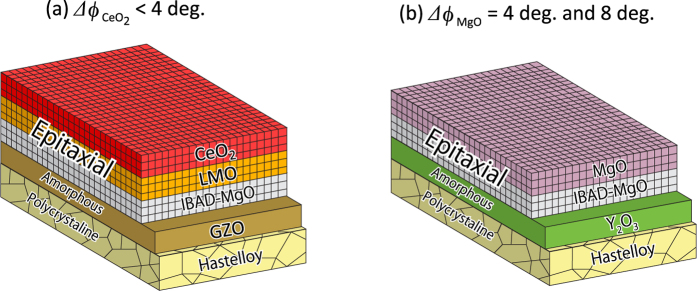
Schematic diagrams of the structures of flexible metal-tape substrates fabricated by the IBAD method.The bottom metal-tape substrate is non-oriented Ni-based Hastelloy. (a) For high-Tc cuprate (ex. REBCO) superconductors. Amorphous Ga2Zr2O7 (a-GZO) as a cation diffusion barrier is first formed, followed by sequential deposition of biaxially textured MgO by the IBAD method, LaMnO3 (LMO) by sputtering, and the top CeO2 layer by PLD to achieve extremely high in-plane orientation with ΔϕCeO2 < 4°1315. (b) For iron-based superconductors (IBAD-MgO). An a-Y2O3 bed layer is deposited on the metal-tape substrate to planarize the surface, followed by sequential deposition of biaxially textured MgO by the IBAD method and a top homoepitaxial MgO layer1214. In this study, we used two types of IBAD-MgO substrate with in-plane alignment of ΔϕMgO = 4 and 8°.